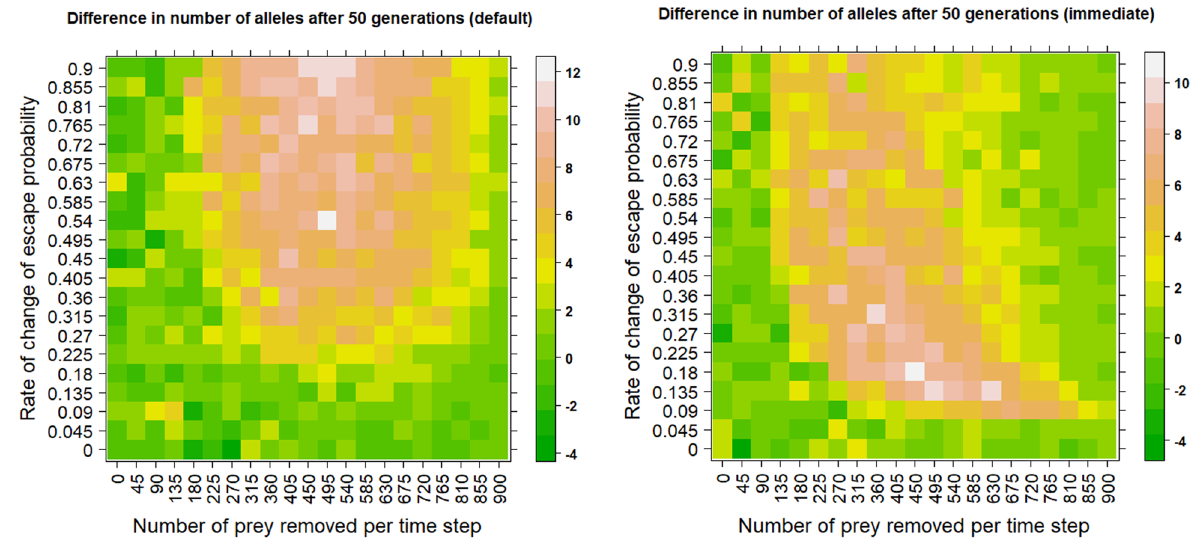
Figure 4. Restriction of maximal possible age makes effects of learning smaller but still noticeable. The heatmaps show the result of simulations with the capped maximum age of 10. Every individual that passed this threshold instantly died. Predators kill the same number of individuals in both learning and non-learning scenarios to allow for a fair comparison. The upper bound on the probability of avoiding or escaping a predator attack is set to 0.99. The values in the heatmap are averages from 10 simulation runs. The learning occurs at the end of each timestep in the left panel and after every unsuccessful predator attack in the right